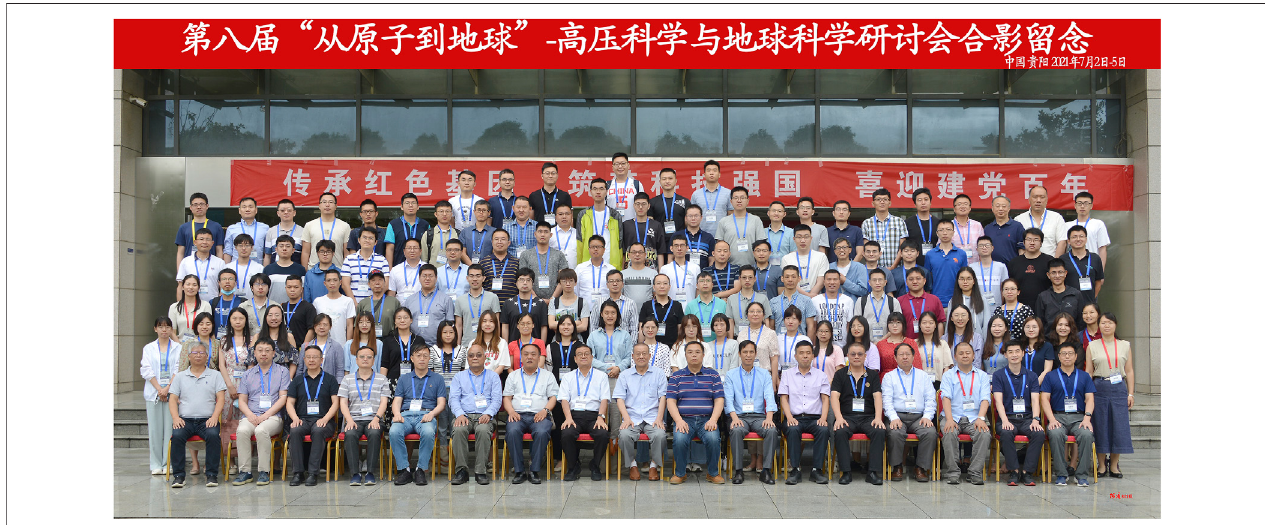
FIGURE 1 | Group photo for the eighth “ From Atom to Earth ” Symposium on High-Pressure Science and Earth Science held in IGCAS, Guiyang, China between July 2nd and fi fth, 2021.